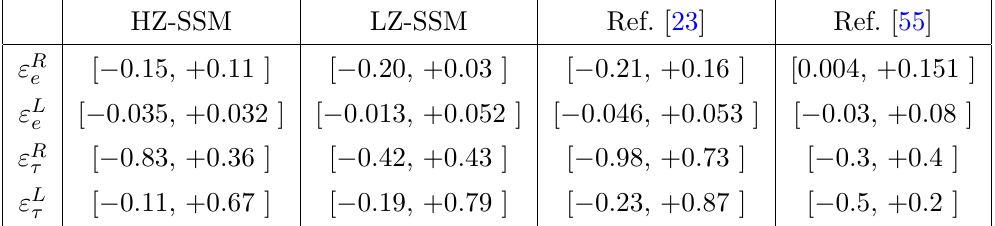
, " L , " R , and e e (cid:28)